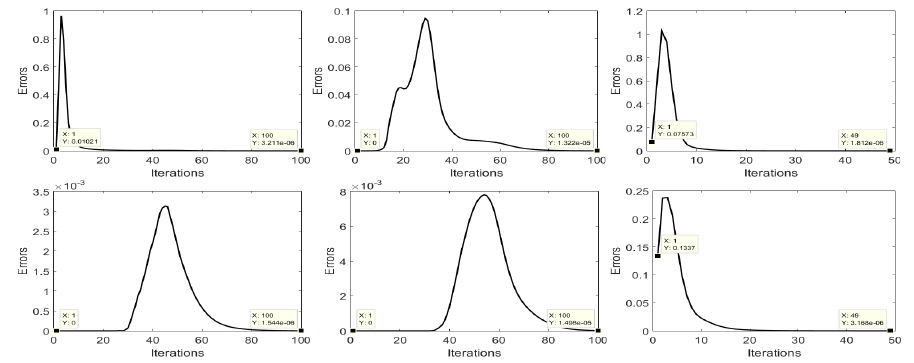
Figure 11. The evolution of the errors (cid:107) Z r + 1 − Z r (cid:107) 2 to the number of iterations for three datasets: Indian Pines (left), Pavia University (middle) and Salinas (right).